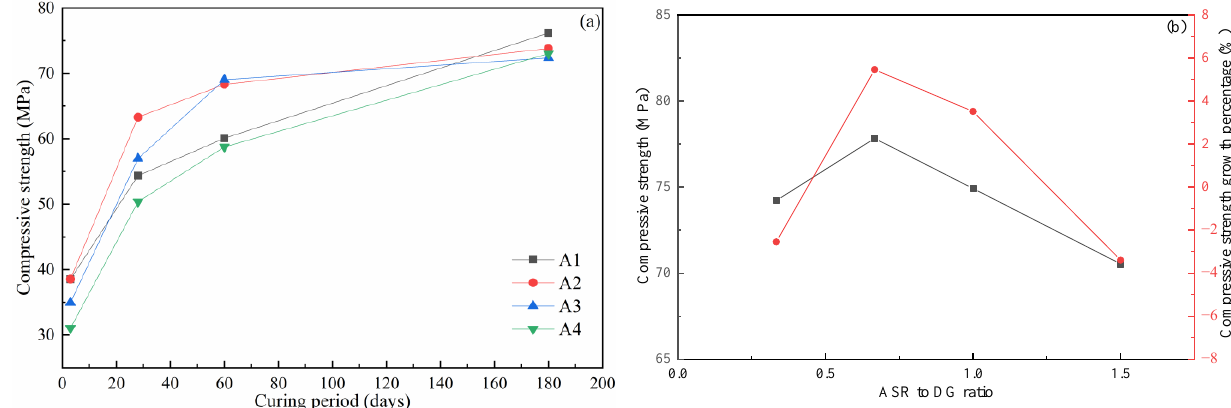
Figure 3. Compressive strength and strength growth of concrete: ( a ) the compressive strength of concrete in different curing period and ( b ) compressive strength and strength growth percentage of concrete after artificial seawater immersing.